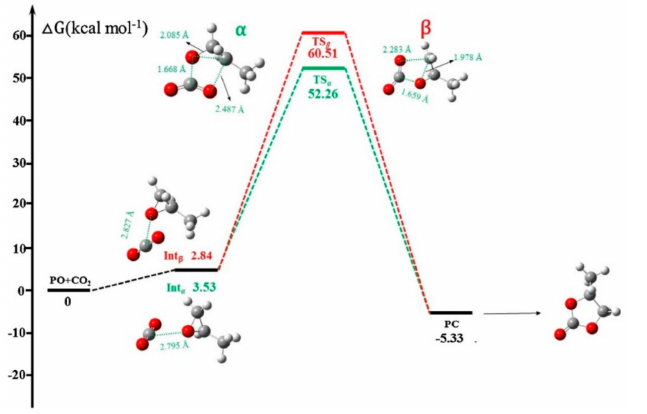
Figure 15. Gibbs free energy surface profile in a non-catalyzed reaction with optimized geometry of intermediates and transition state. Reprinted with permission from Ref. [67]. Copyright 2018